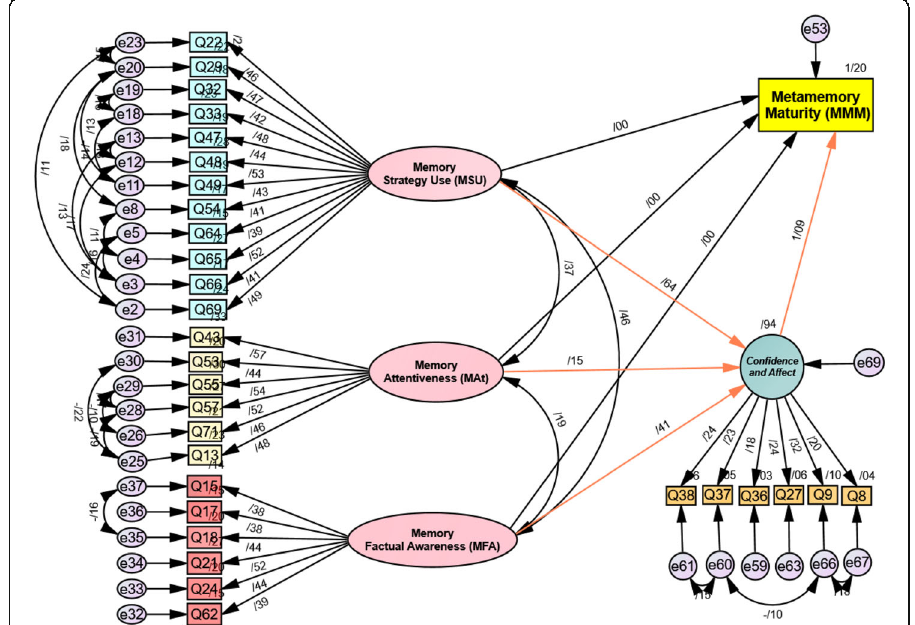
Fig. 3. Schematic representation of the final model of the MMM